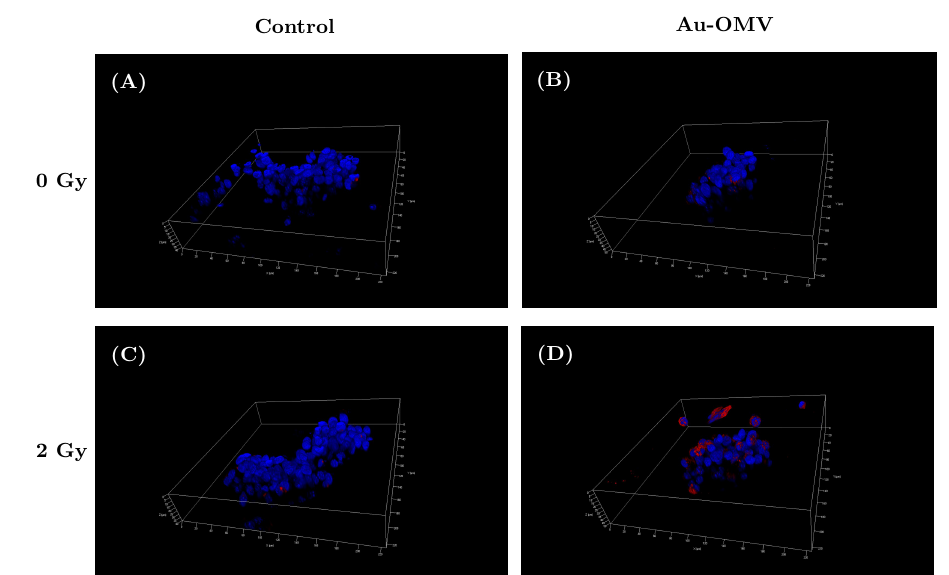
Figure 6. ROS production of live G261 glioma cells grown on 3D spheres in control ( A ), in response to ( B ) Au–OMV, ( C ) 2-Gy radiotherapy, and ( D ) the combination of Au–OMV and radiotherapy under confocal microscopy. The live cells were labeled with H33342/DAPI (blue for nucleus), phalloidin (green for actin), and CellROXTM Deep Red Reagent for oxidative stress detection (pink for ROS).